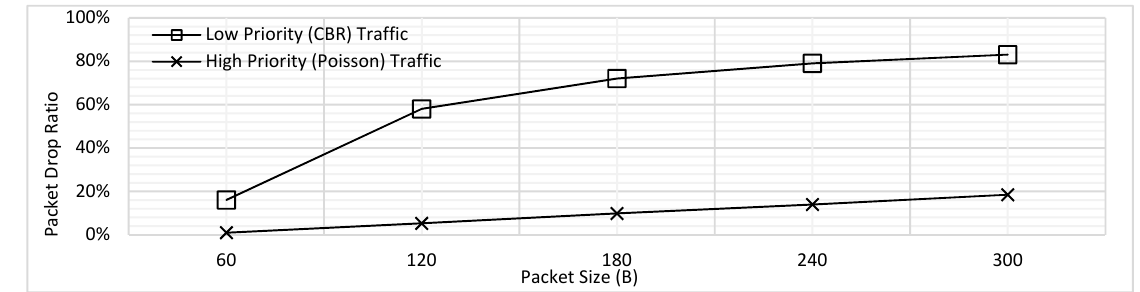
Figure 4. Packet Drop Ratio (PDR) of Low and High Priority Traffic for FCFS Scheme.